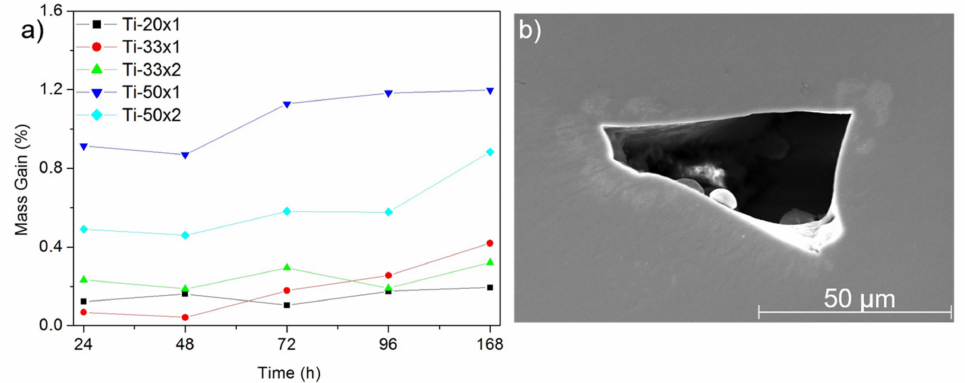
Figure 14. ( a ) Evolution of the mass gain of the specimens with immersion time; ( b ) detail of a defect of the material Ti-20 × 1 after 168 h of immersion